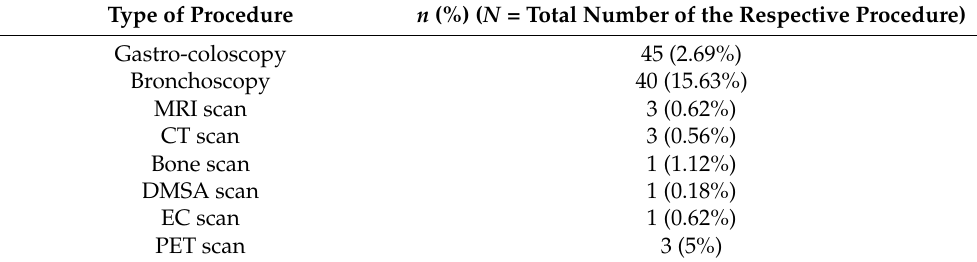
Table 10. Occurrence of adverse event according to type of procedure (one procedure could result in several adverse events (Table 9).